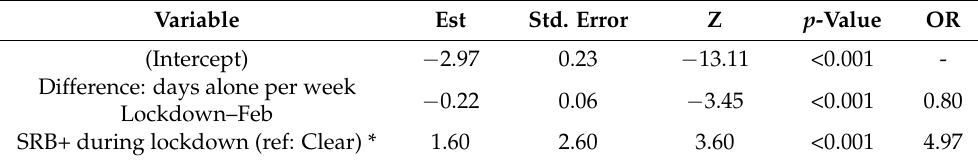
Table 2. Results from the final multivariable logistic regression for n = 1407 dogs who were Clear of SRB signs in February 2020. The dependent variable is SRB status in October 2020, of which n = 1070 were classified as still Clear (coded as 0) in October, but n = 117 had transitioned to being SRB+ (coded as 1) and n = 220 were not being left in October so had a missing SRB status and were excluded from this analysis. * Denotes variables treated as categorical. Unless otherwise indicated, variables were treated as continuous.